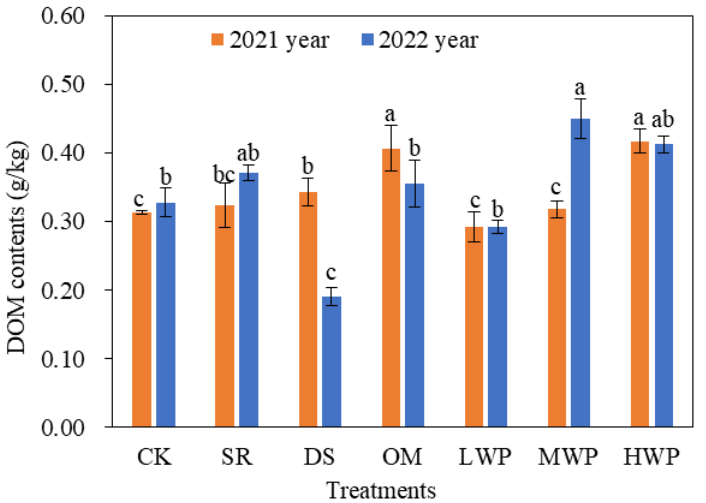
Figure 2. Changes in soil dissolved organic matter (DOM) content under different treatments in 2021 and 2022. Vertical bars denote the standard error of the mean ( n = 3). Different letters, a, b, and c, indicate significant differences between treatments in the same year at p < 0.05.